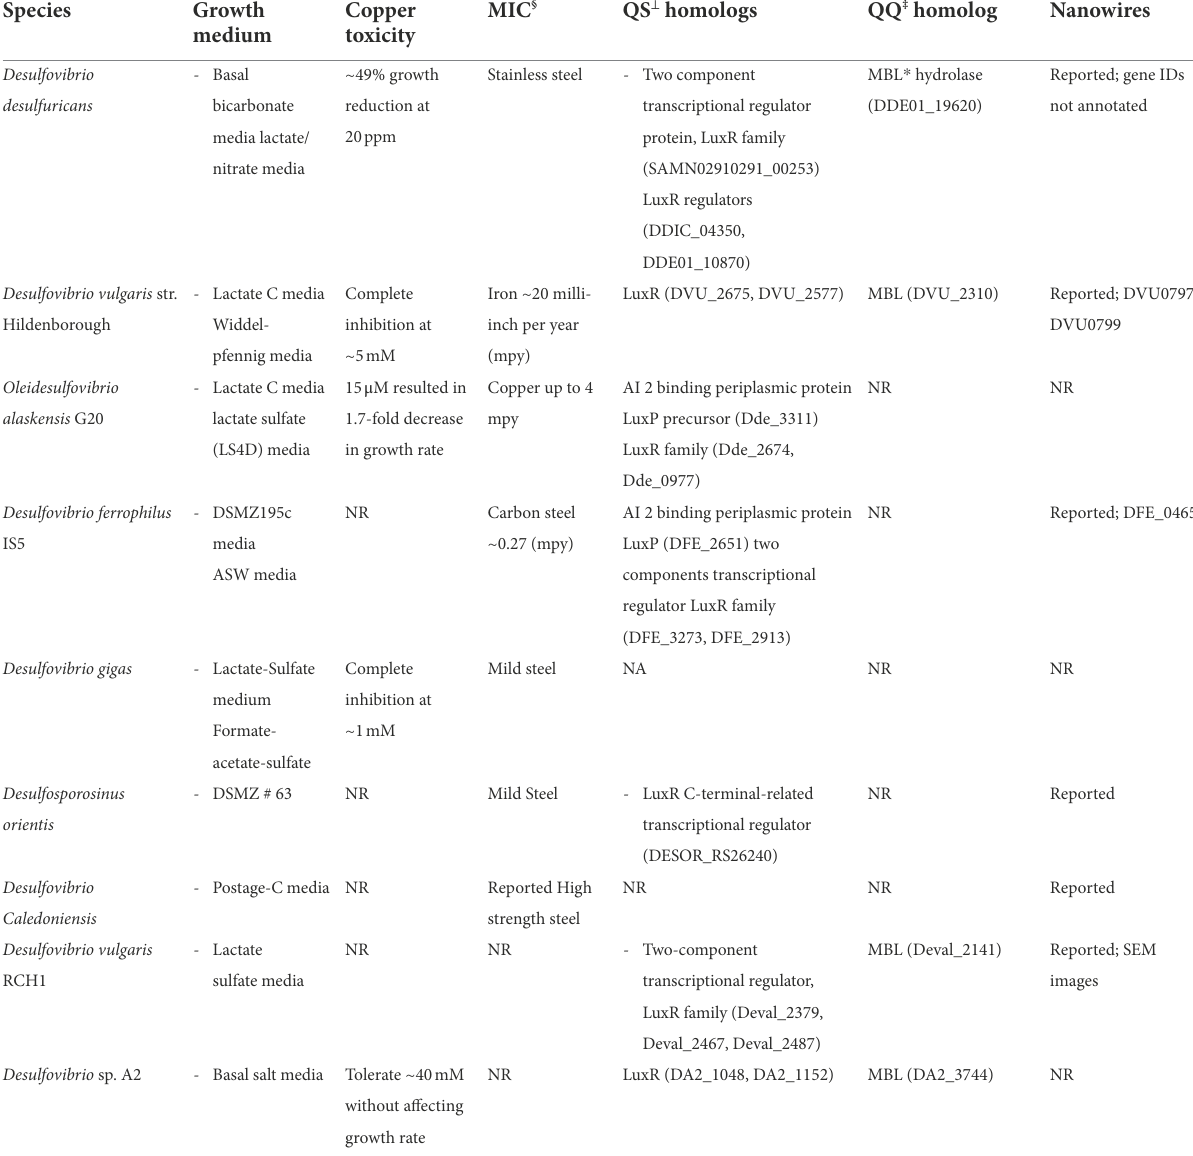
TABLE 3 Overview of significant characteristics reported for different strains of the sulfate reducing